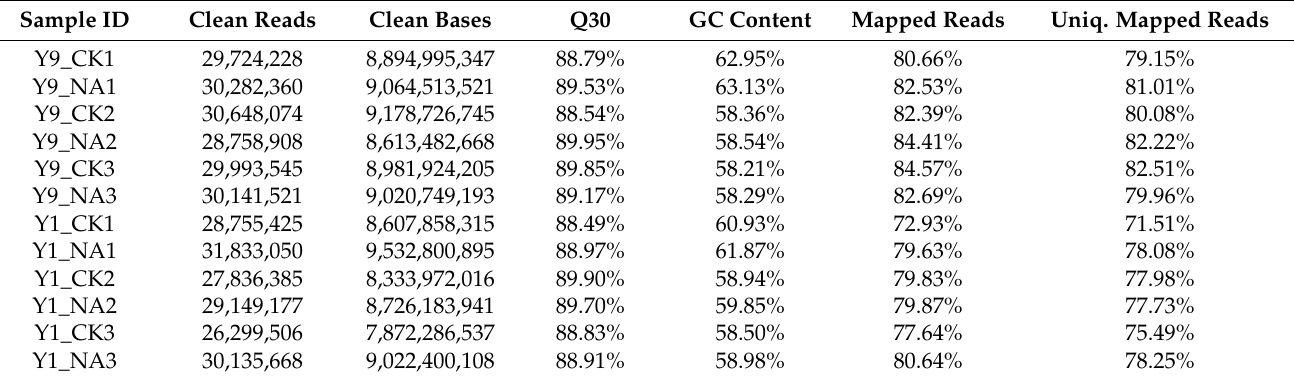
Table 2. Information of the sequencing